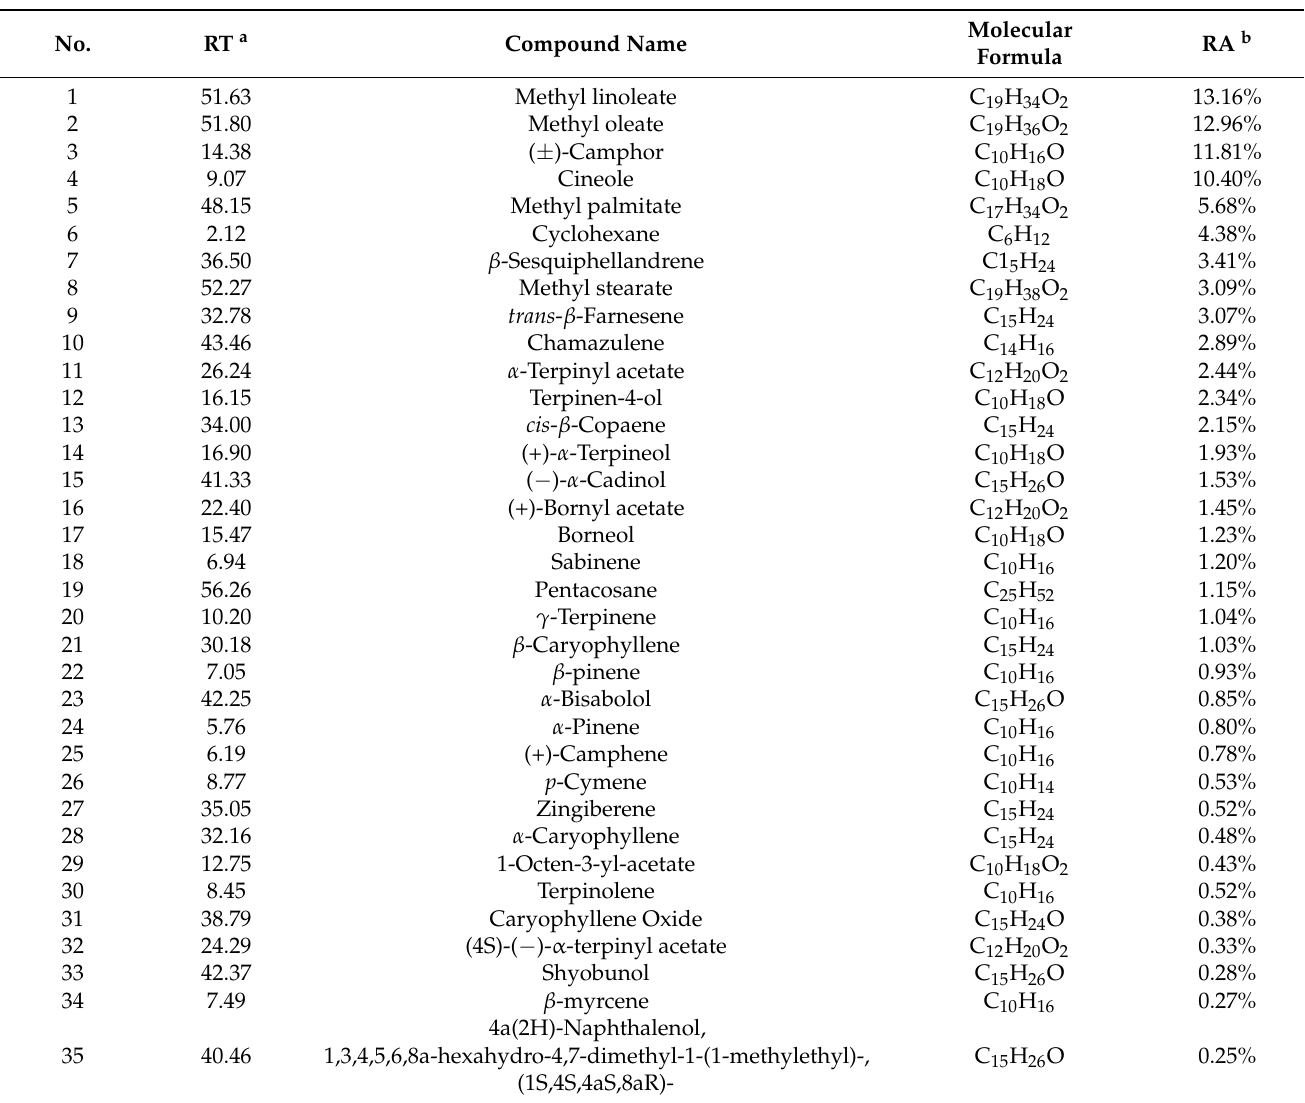
Table 2. Chemical composition of